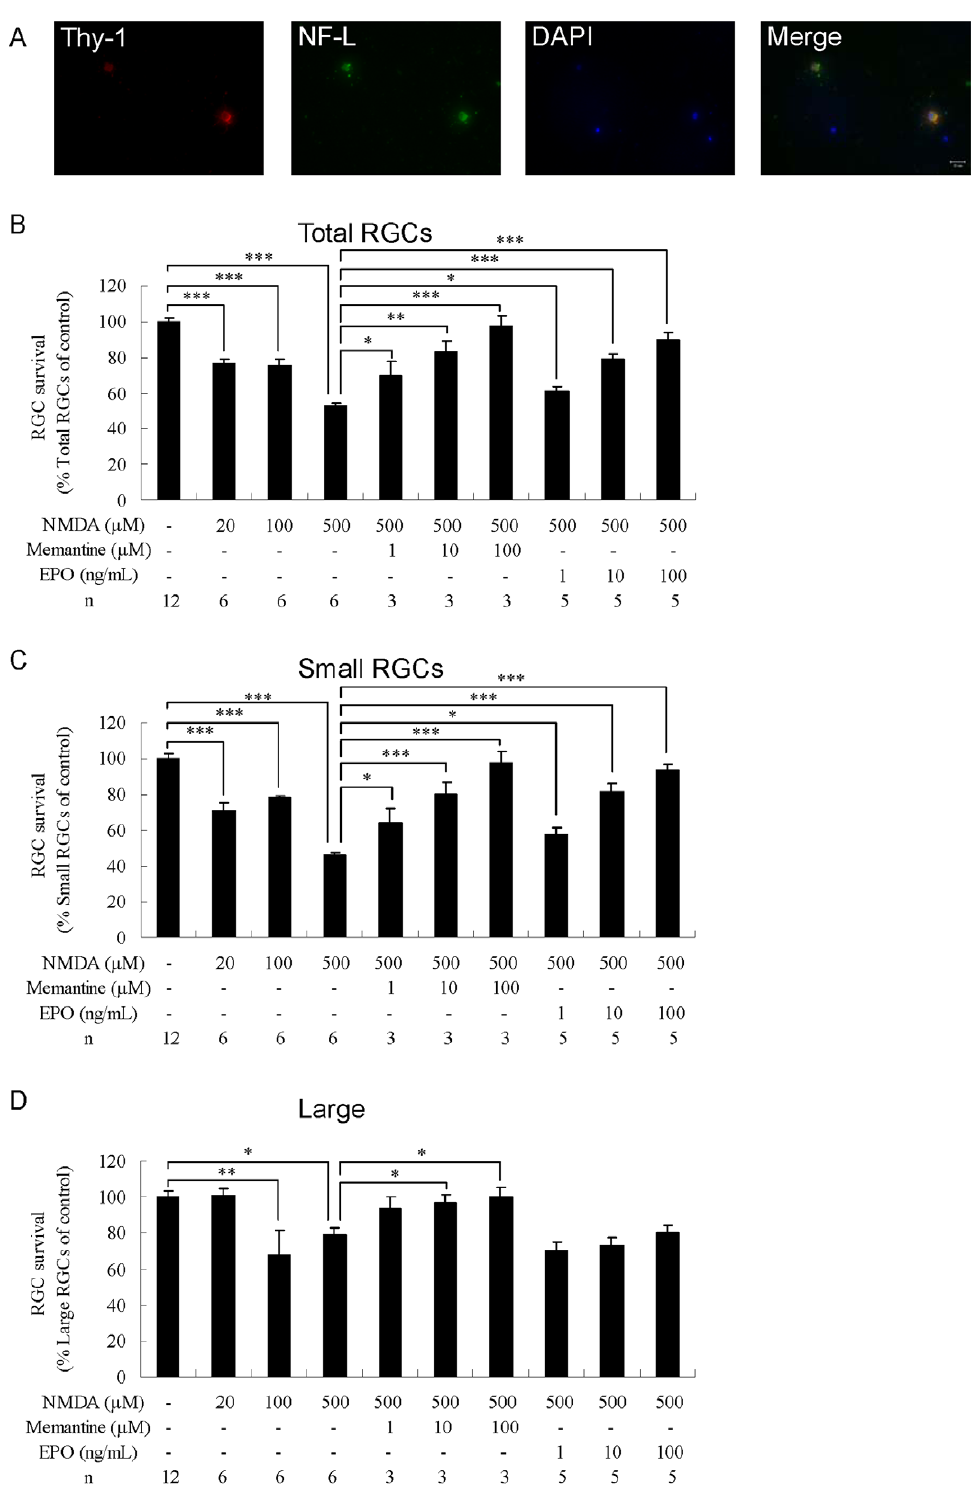
Figure 2. Effects of erythropoietin on total, small, and large RGCs under NMDA-induced toxicity. (A) Morphology of NMDA-treated RGCs. The cells were cultured in a medium supplemented with 500 m M NMDA. After culturing, RGCs were immunostained with anti-Thy-1 antibody (red) and anti-NF- L antibody (green), and DAPI nuclear staining (blue). Survival rate of (B) total, (C) small, and (D) large RGCs. The cells were treated with vehicle: NMDA (20–500 m M) alone, NMDA (500 m M) + memantine (1–100 m M), or NMDA (500 m M) + EPO (1–100 ng/mL). The number of RGCs was counted and normalized versus the control group. Data are presented as mean 6 standard error of the mean (n=3–12). Data were statistically analyzed by 1-way ANOVA, followed by the Dunnett’s test. *P , 0.05, **P , 0.01, and ***P , 0.001.